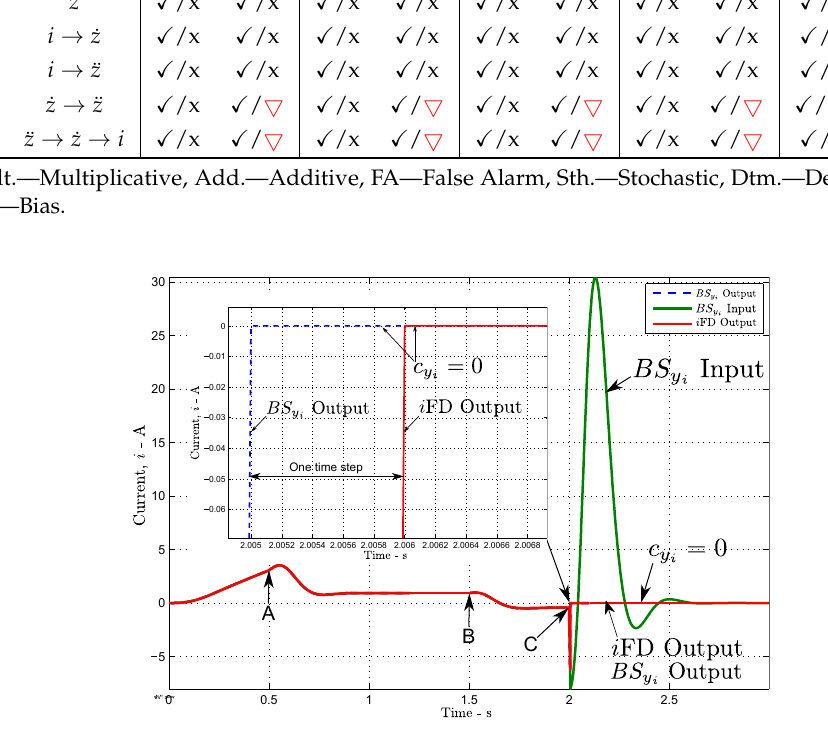
Figure 9. Input-output of the BS y of the current sensor, i , and the output of the i FD. i Sensor FD time investigation is seen on Table 3. Column-wise: column 1 maps the identifier number for the chosen scenario, column 2 lists the sensors (remark: underlined channels indicate faulty ones with incident occurring at t f which is shown column 3). The rest of the columns refer to FD time, t d , in particular the ones marked using boldface font indicated fault occurrence is detected (while boldface entries with superscript “*” are the false